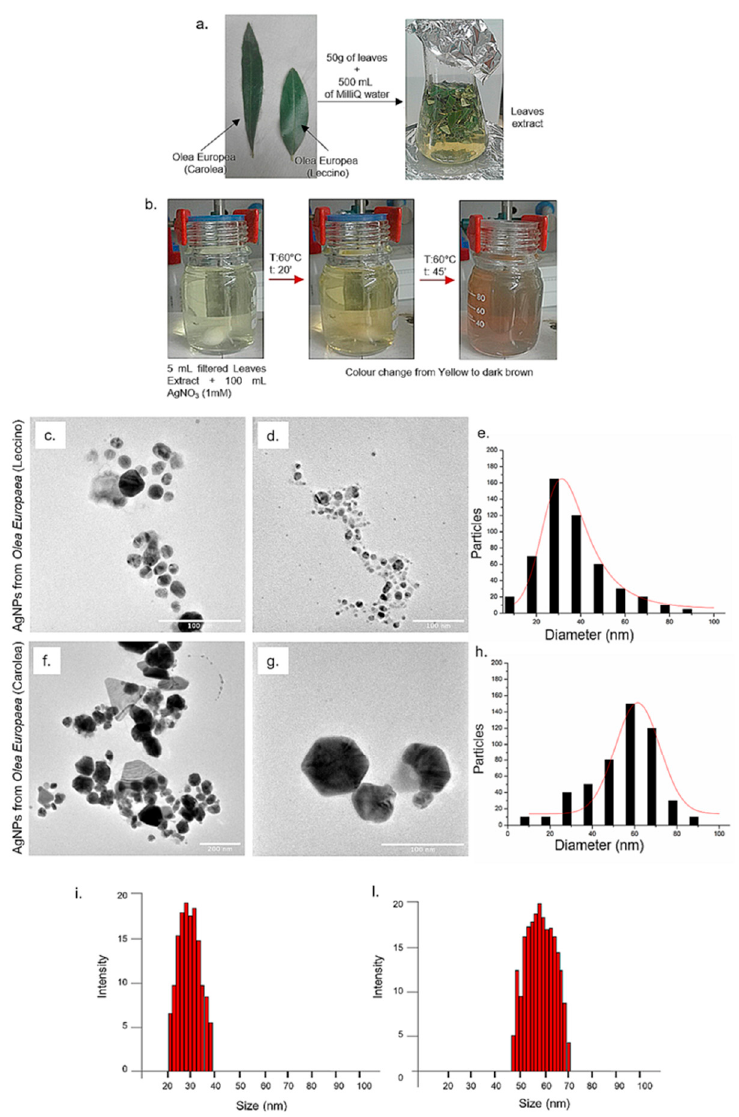
Figure 1. Morphologic differences between leaves collected from Leccino and Carolea cultivars and leaves extract preparation ( a ). The reaction started with AgNO 3 addition and the change of colour from yellow to dark brown indicated silver NPs (AgNPs) formation ( b ). Representative TEM images of AgNPs obtained from Olea Europaea Leccino ( c –d) and from Carolea ( f – g ) at pH 7. Size distribution was measured on 500 AgNPs from Leccino ( e ) and Carolea ( h ) and fitted with a normal function (solid line). Dynamic Light Scattering (DLS) measurements in water of AgNPs from Leccino ( i ) and Carolea ( l ) at pH 7. Afterwards, ζ -potential analyses revealed that negative surface charge was observed for all the obtained AgNPs in water (Table 1). This can be ascribed to proteins and other biological molecules present in leaves extracts, adsorbed on the NPs surface [53]. In fact, during green synthetic process, biomolecules such as proteins and peptides behave as capping agents and they are typically adsorbed during the NPs formation step, a ff ecting the reaction dynamic and the NPs growth in di ff erent directions. These negatively charged natural capping agents are responsible of NPs stabilization due to their ability to control particles size, shape / morphology and to protect the surface from agglomeration phenomena that will influence their consequent uptake in cells